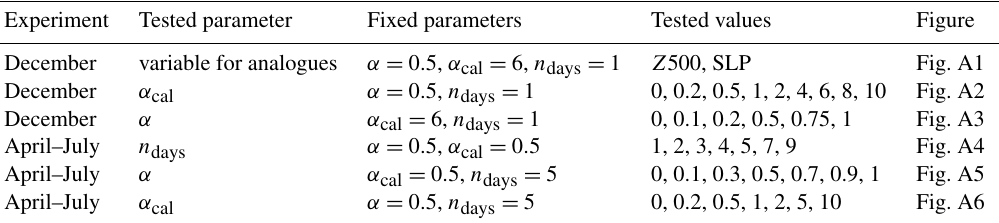
Table 2. Performed sensitivity tests for the parameters used to simulate warm Decembers (first three rows) and wet April–July periods (last three rows). The second column lists the parameters of which the sensitivity is assessed. The third column indicates at which levels all other parameters are fixed for the test. The fourth column lists all tested values and the last column indicates the figure where the results of the test are shown. Tested